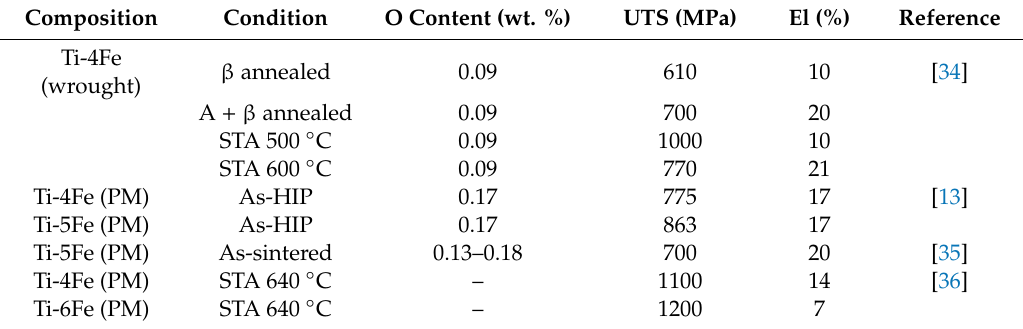
Table 3. Tensile Properties of Ti-xFe Alloys from the